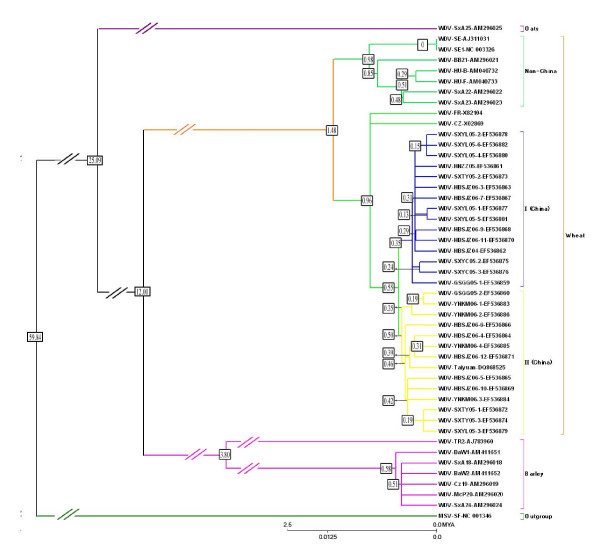
Phylogenetic tree deduced from the complete genomic sequences of 46 WDV isolates from wheat, barley and oats produced by Neighbor Joining using the Kimura 2-parameter model. Terminal branch colors identify two clades of isolates collected from wheat in China (yellow, blue), or in other countries (light green) and oats or barley (purple). Maize streak virus (NC_001346, dark green) was used as an outgroup.